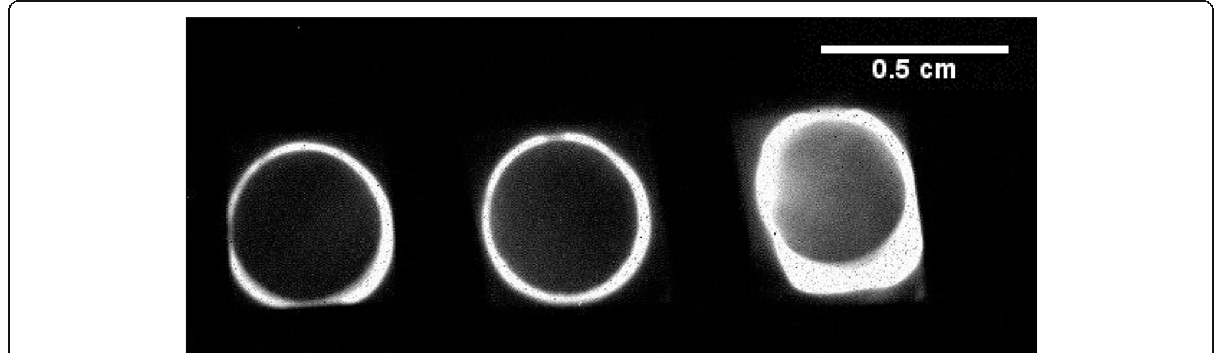
Fig. 11 Represent the signal after the addition of artificial saliva spiked with cortisol standard solution 10 ng ml − 1 . The scale bar is 0.5 cm